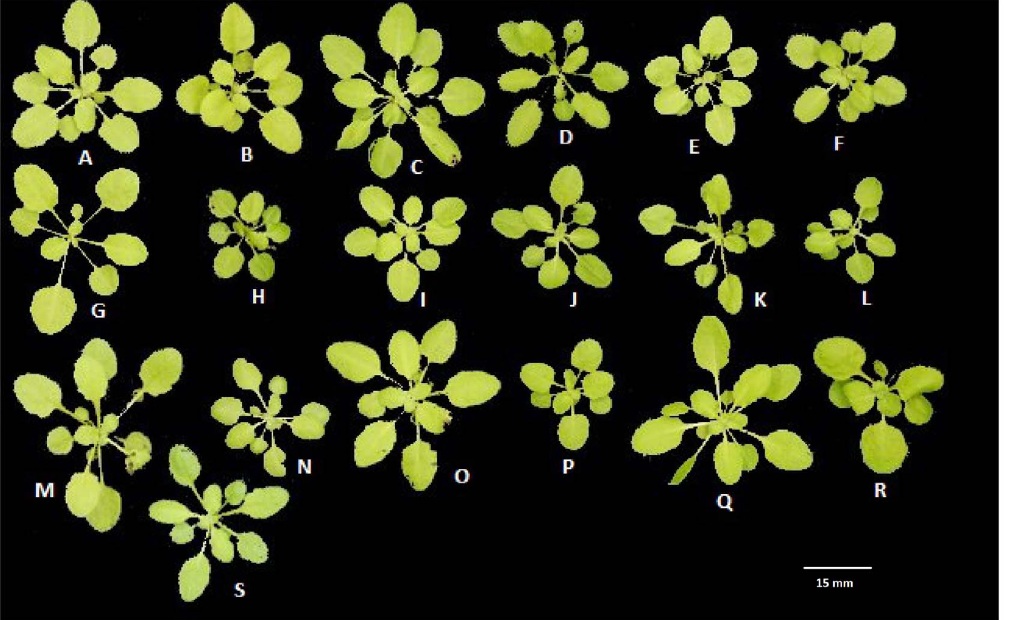
Figure 1. Images of representative plants of the 19 parental lines [1] at 28 DAS. (A) EDi-0, (B) Can-0, (C) WS-0, (D) Hi-0, (E) Zu-0, (F) Po-0, (G) Sf-2, (H) Wil-2, (I) 0y-0, (J) Kn-0, (K) Ct-1, (L) Wu-0, (M) Tsu-0, (N) Col-0, (O) Rsch-4, (P) No-0, (Q) Bur-0, (R) Ler-0 and (S) Mt-0.